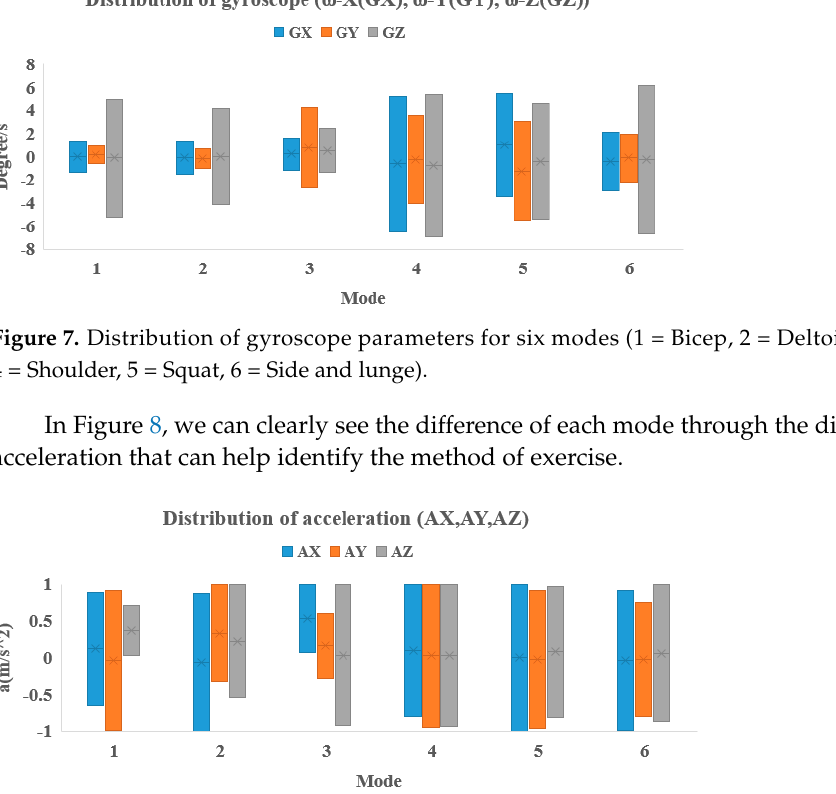
Figure 8. Distribution of acceleration parameters for six modes (1 = Bicep, 2 = Deltoid, 3 = Tricep, 4 = Shoulder, 5 = Squat, 6 = Side and lunge).